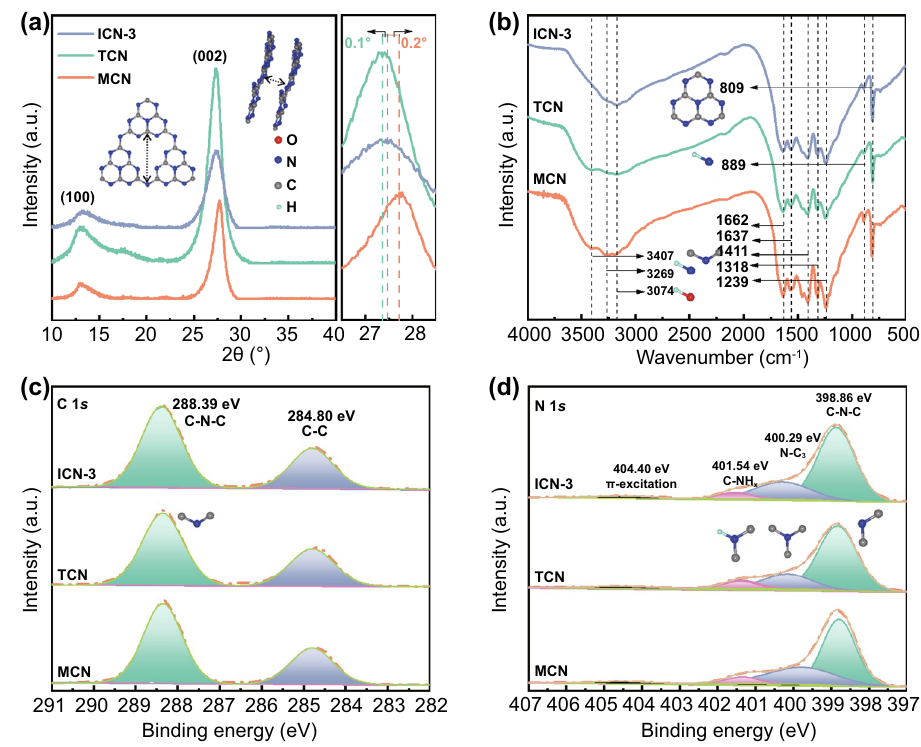
Fig. 1 a XRD patterns, b FTIR spectra, c XPS for C 1s and d N 1s spectra of ICN-3, TCN and